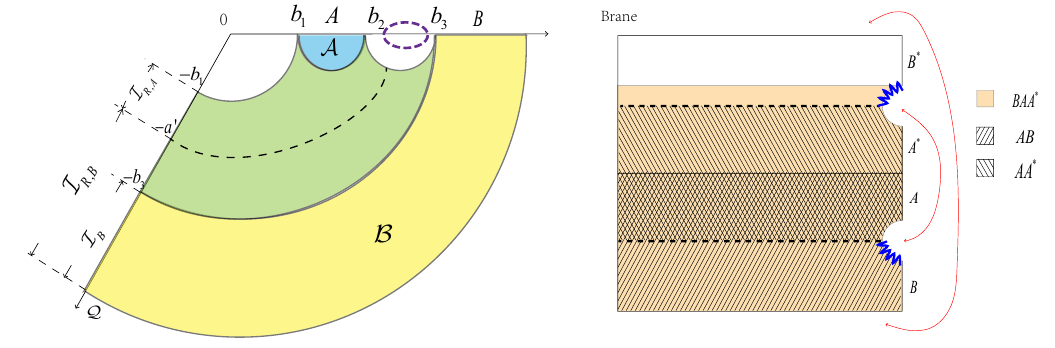
Figure 7 . Phase-D3. A and B are disjoint. A admits no entanglement island but a reflected island. There is one boundary of EWCS, denoted by a dashed curve, and one gap between A ∪ I R,A and B ∪ I R,B , indicating h ≥ c log 2 . There is a jagged surface in this phase denoted in blue. 3